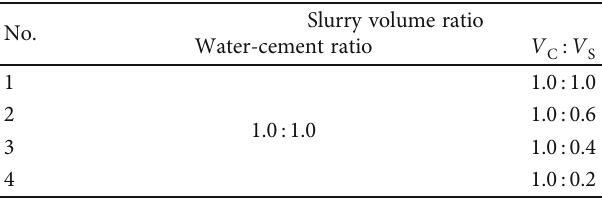
Table 4: Cement slurry-sodium silicate (C-S) volume